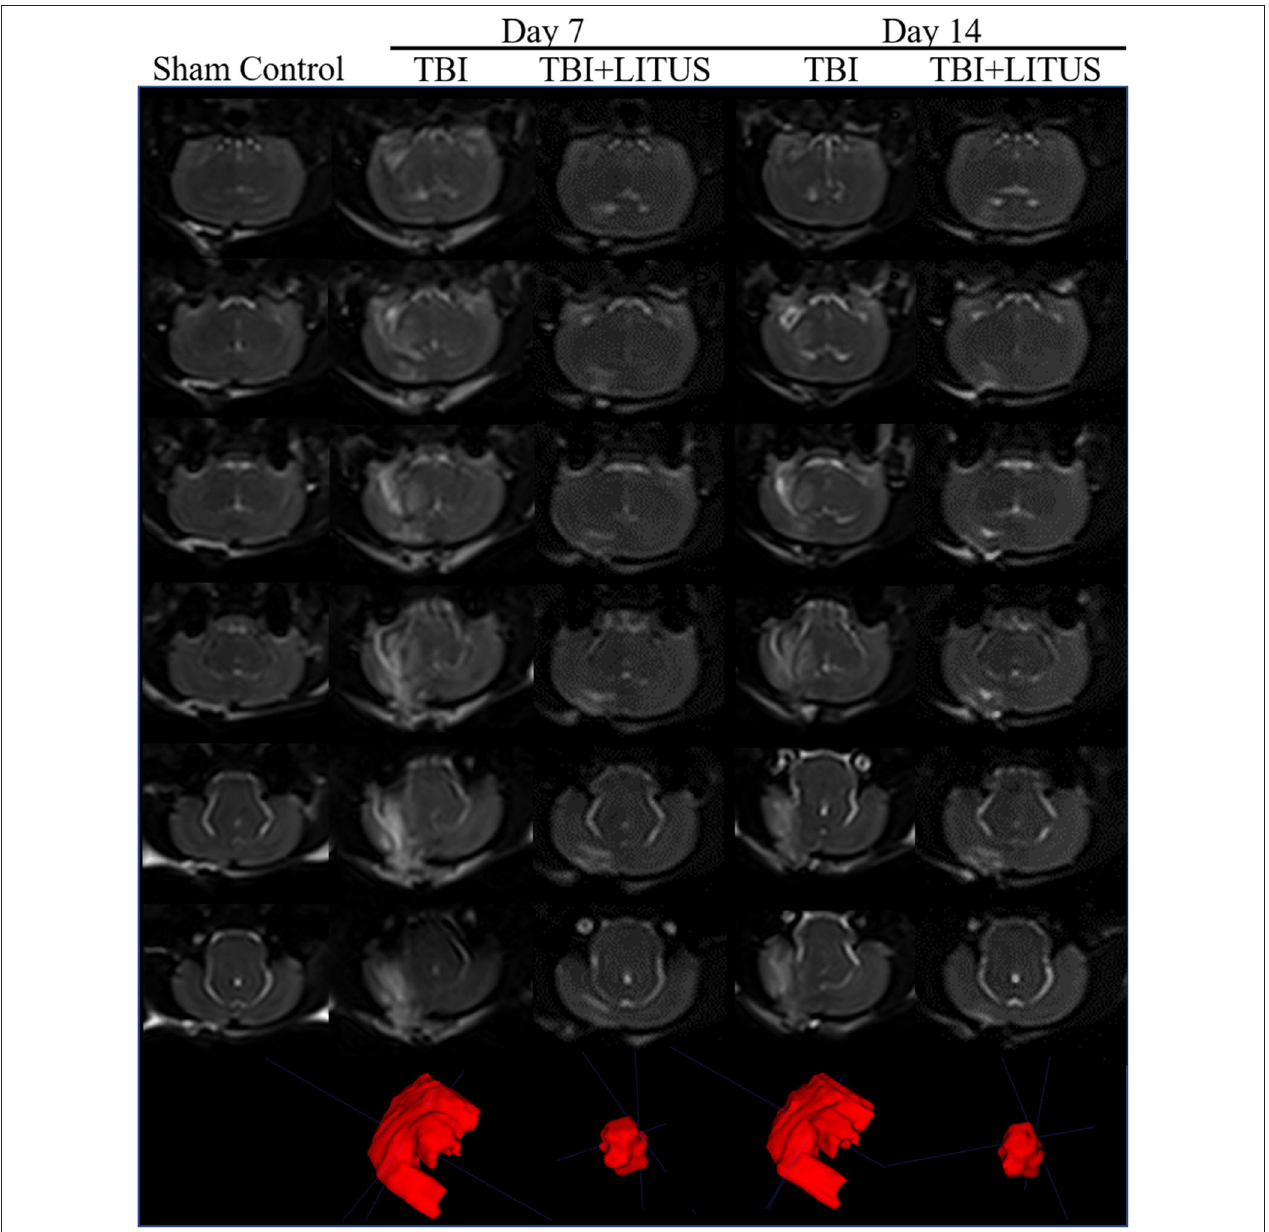
FIGURE 5 | Volume of edema on 3D-T2WI. Representative 3D T2-weighted MRI images at 7 and 14 days post-TBI. The areas with high signals in the figure represent the edema areas in the brain after TBI, and the edema areas of TBI + LITUS are significantly smaller than those in the TBI group ( n = 15).